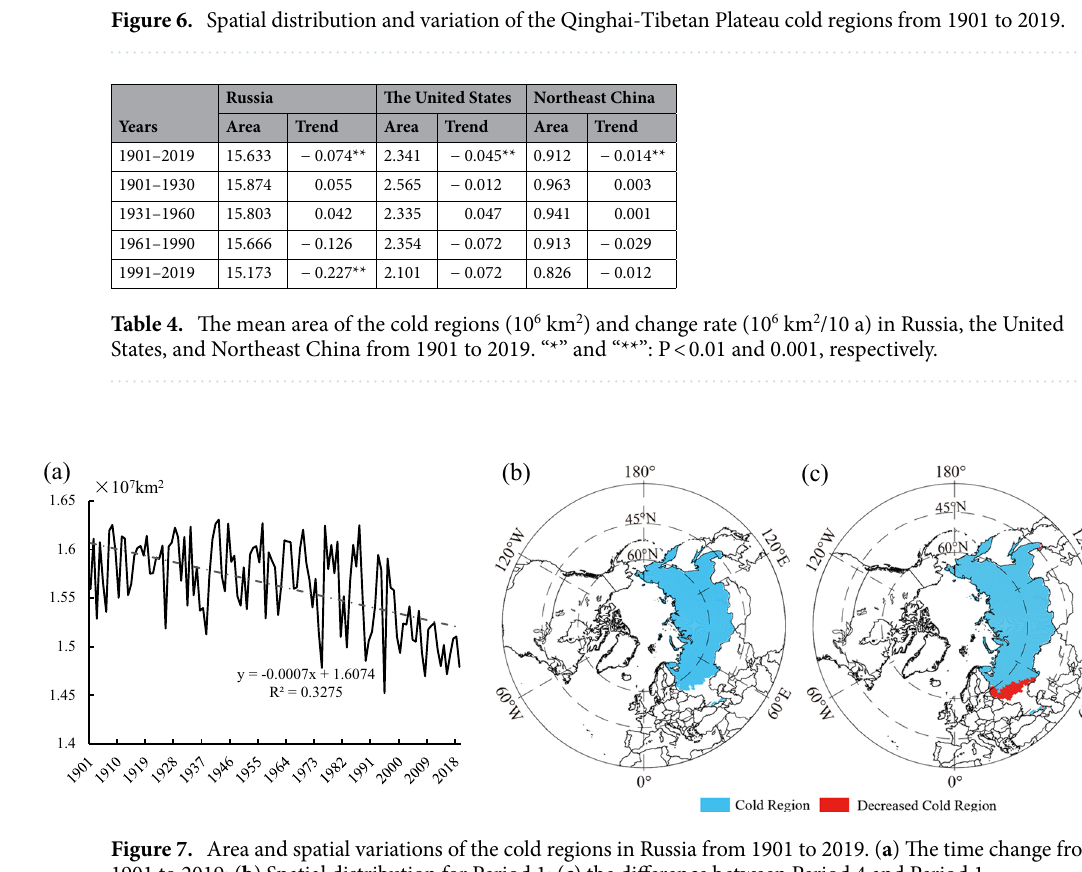
Figure 7. Area and spatial variations of the cold regions in Russia from 1901 to 2019. ( a ) The time change from 1901 to 2019; ( b ) Spatial distribution for Period 1; ( c ) the difference between Period 4 and Period